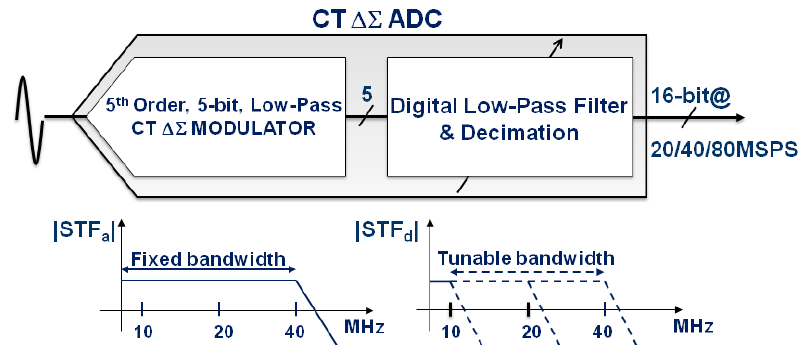
Figure 1. Architecture of the proposed variable-rate CT ∆Σ ADC